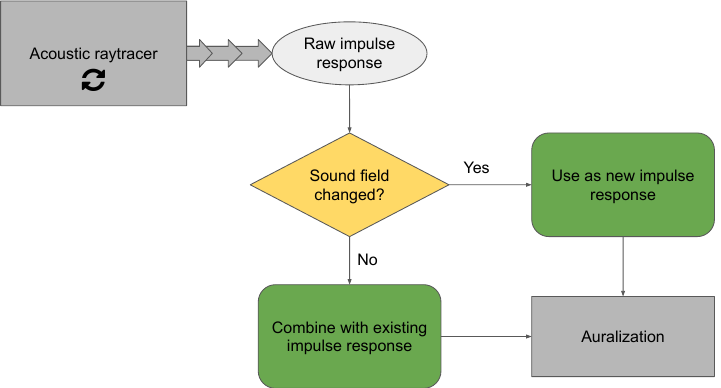
Figure 1. Flowchart illustrating the suggested algorithm. The ray tracer runs continuously, producing new simulated impulse responses (grey oval) as often as possible. For each new impulse response, the iterative algorithm determines whether the sound field has changed significantly or not since the last impulse response (yellow rhombus). If it has not, the simulation result is used to iteratively improve the existing impulse response. If it has, the simulation result is taken as a new impulse response. The final chosen impulse response is then passed on to the auralization